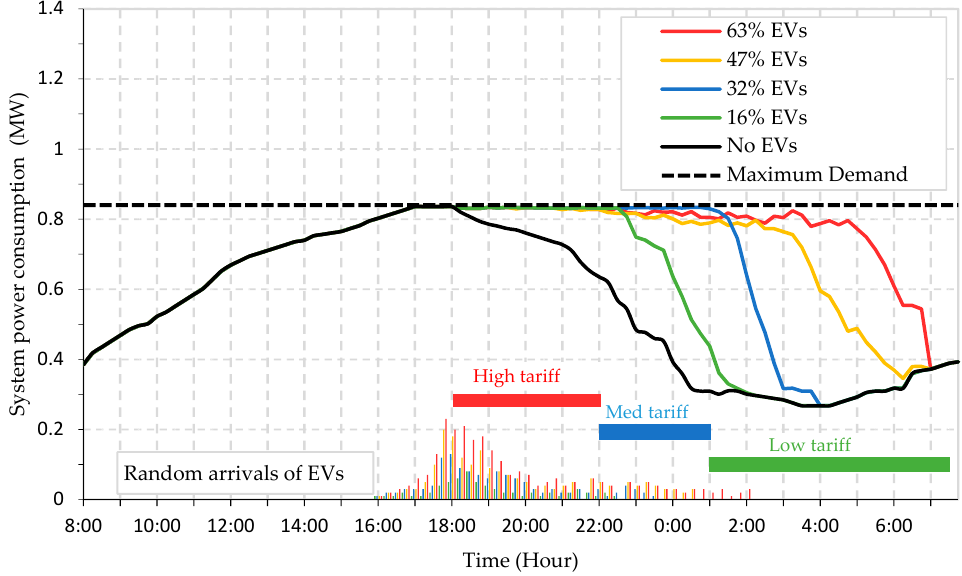
Figure 9. Impact of coordinated EVs’ charging on system power consumption. This case shows that the voltage drops at all the nodes are within the permissible limits of utility even under high EV penetrations as shown in Figure 10. Referring to Figure 11, there can be seen a significant reduction in total system power losses as compared to Figure 8. Overall, this algorithm satisfies all the parameters except the cost-effective one. In this case, charging has been started from high tariff (red zone) even for low penetration levels, so the cost of charging is high. For low and medium penetration levels, EVs can be facilitated in the low-tariff zone (green zone) instead of charging them in high price zone. To make this algorithm cost effective, the concept of optimal charging starting time (OCST) is considered.